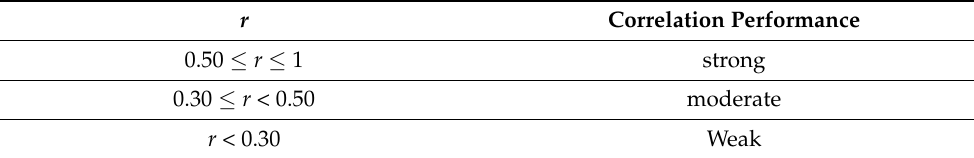
Table 2. Threshold values to evaluate correlation performance.